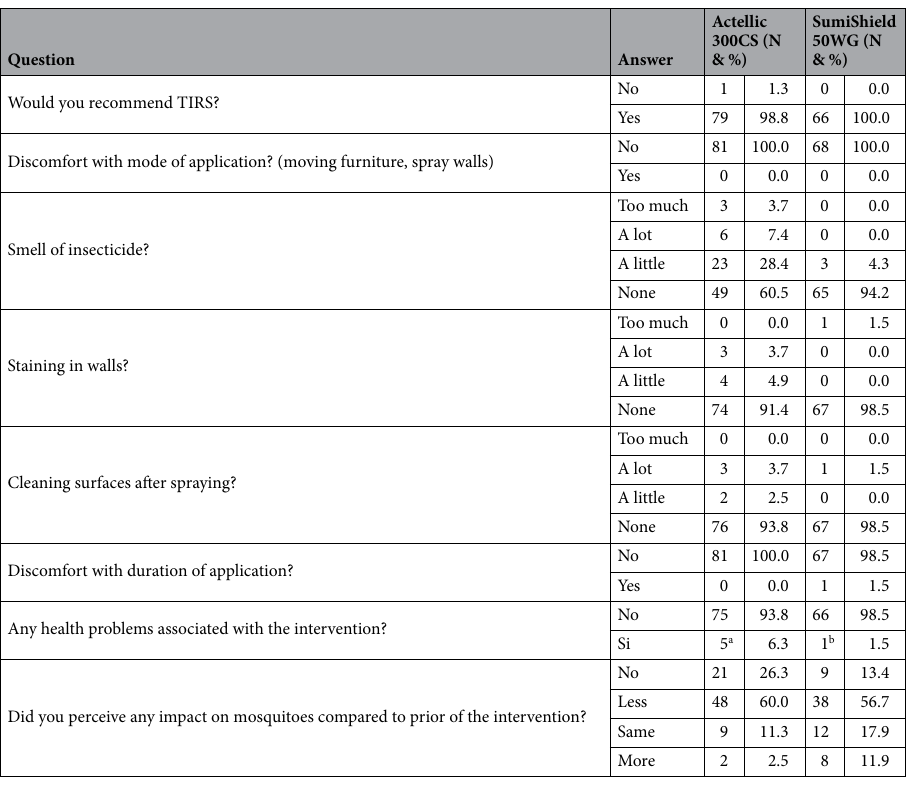
Table 1. Social perception and acceptability of preventive TIRS. Surveys conducted in 150 houses receiving either Actellic 300 CS (N = 81) or SumiShield 50 WG (N = 68) and conducted 3 mpi (July 2019). a 1 headache, 1 eye irritation, 3 flu-like symptoms. b Sneezing due to smell.